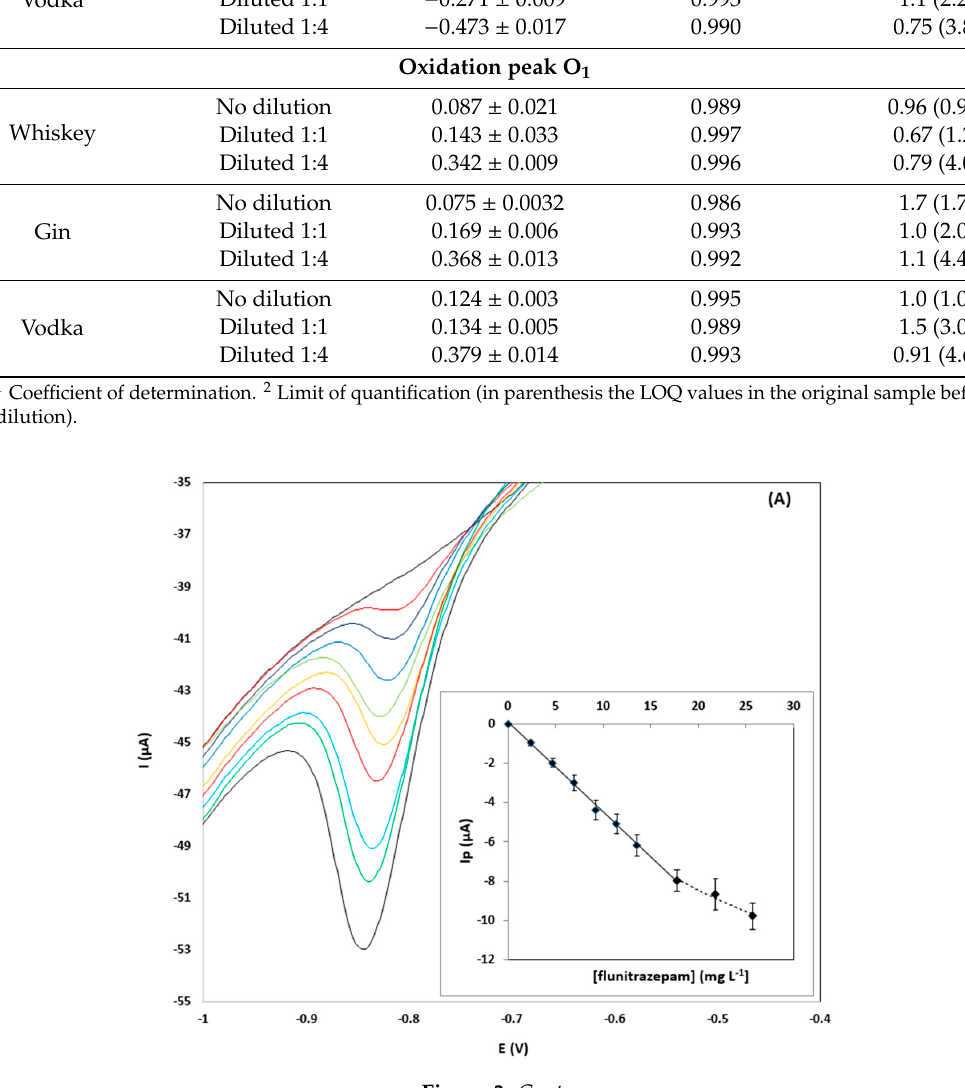
Figure 3. CVs for the determination of 0–25.7 µg L − 1 of flunitrazepam in a pooled gin sample diluted 1:1 ( v / v ) using the drop-volume detection format using: ( A ) the reduction peak R 2, and; ( B ) the oxidation peak O 1 . 3.3. Interference Study No peaks interfering with the analytical peaks of flunitrazepam were observed in the CVs of the whiskey, vodka and gin samples analyzed, therefore no endogenous redox species in the samples interfered electrochemically with the detection of the target compound. The interference study included the two other main date-rape drugs [2], gamma-hydroxybutyric acid (GHB) and ketamine, as well as scopolamine which is also well known to be used for predatory purposes [19]. None of these compounds produced peaks in the CV scan or caused any change in the flunitrazepam peak heights (Figure S2, Supplementary Materials). Indeed, GHB is known to be oxidized only under very specific conditions [18] while both ketamine [20] and scopolamine [19] are oxidized at more positive potentials.